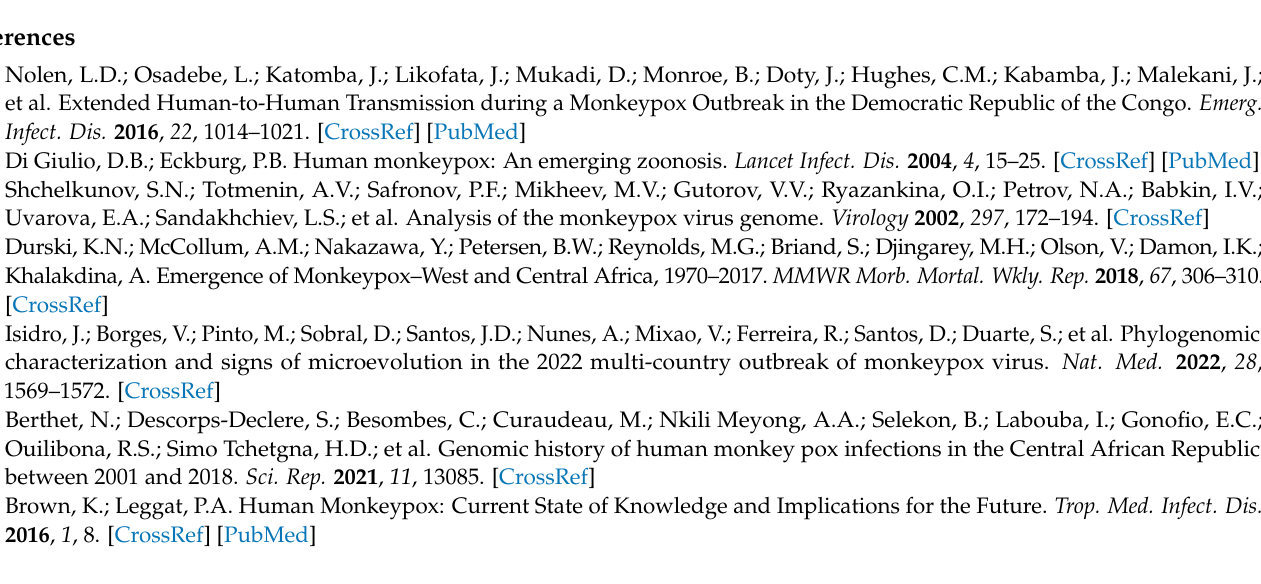
assay; Table S1: Primers sequences used for the detection of the mpox via LAMP assay and qPCR; Table S2: Detailed information of mpox biological samples used in this